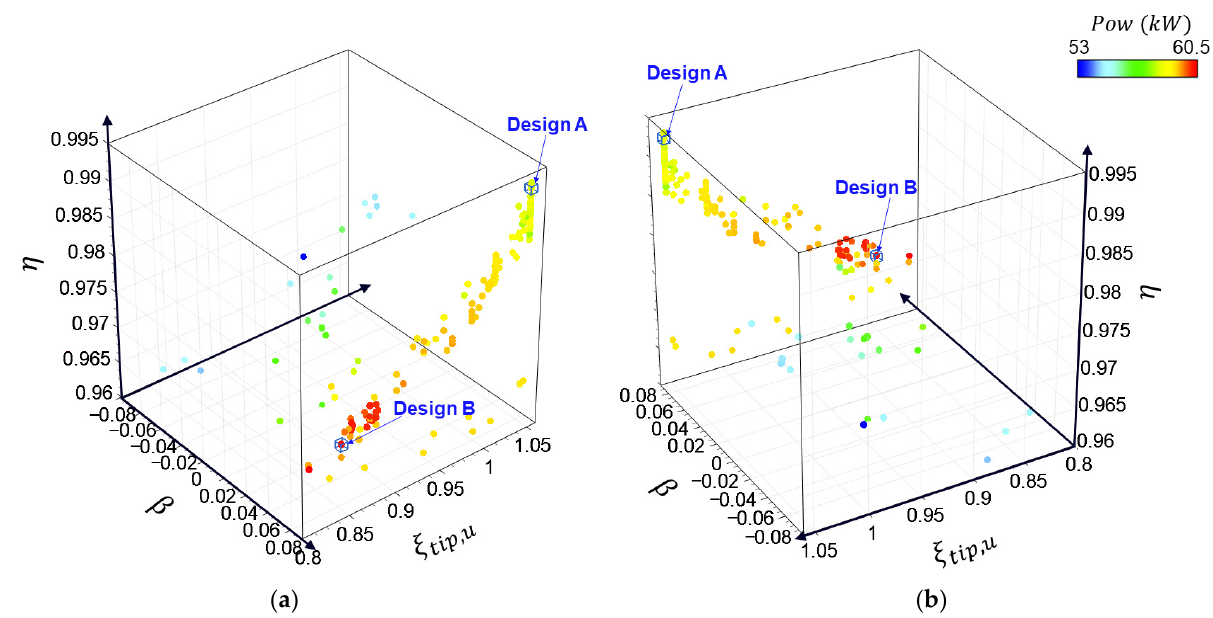
Figure 10. Two views of a 3D plot showing efficiency, power, lean angle, and tip upper surface scaling factor of all designs: ( a ) a normal view; and ( b ) a view obtained by rotating the left-side plot around the 𝜂 axis by 180°.